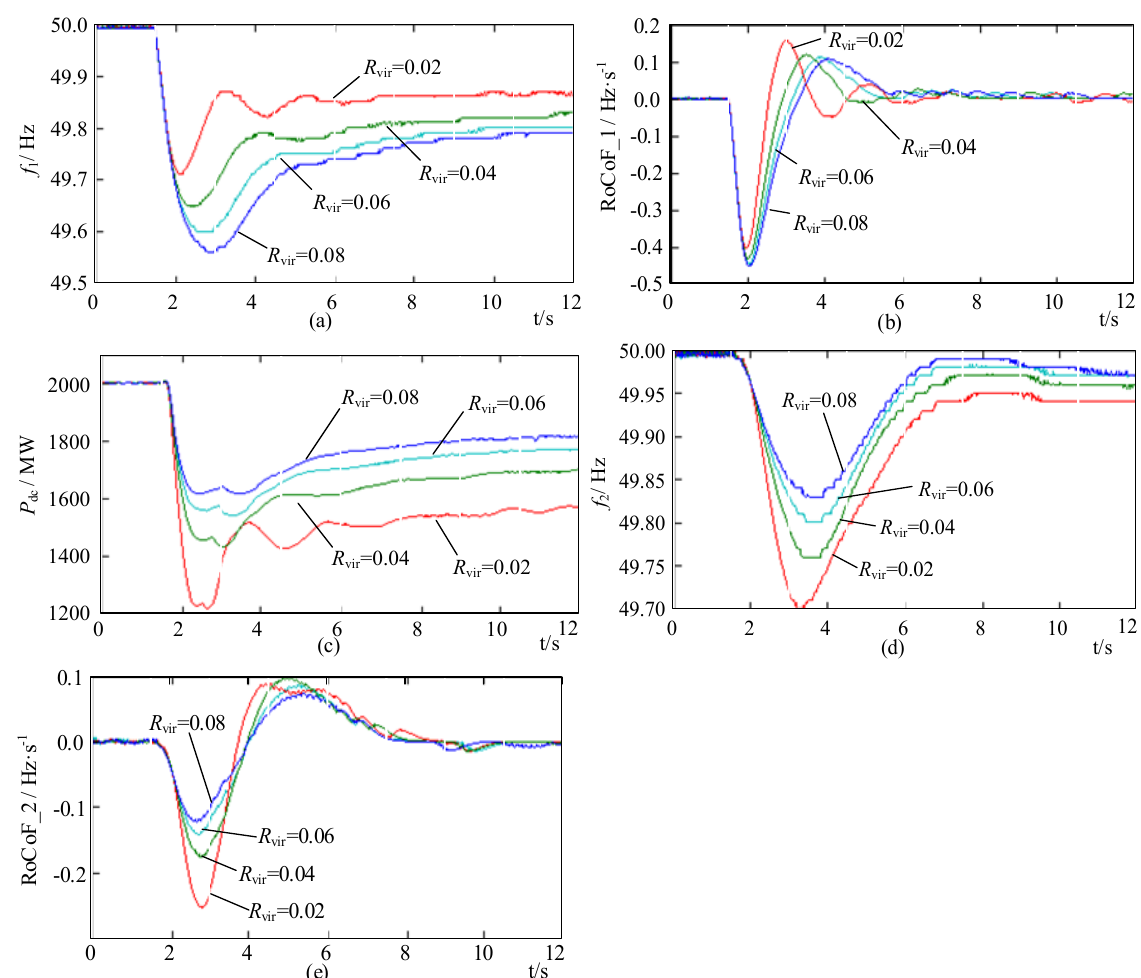
Figure 13. Response with different droop coefficients. ( a ) The frequencies of the sending-end system; ( b ) the RoCoF of the sending-end system; ( c ) the actual power transmitted by the UHVDC; ( d ) the frequencies of the receiving-end system; ( e ) the RoCoF of the receiving-end system. Table 4. Calculated and simulation results under different control modes (load increase) .